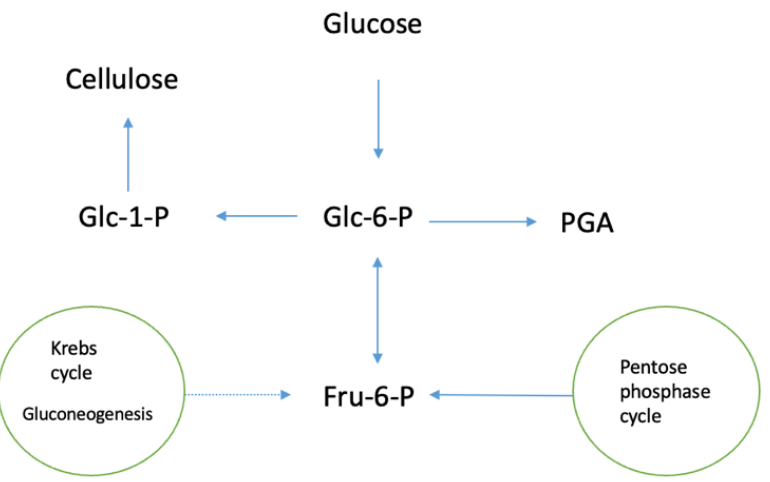
Figure 3. Pathways of carbon metabolism in Acetobacter xylinum , CS, cellulose synthase (adapted from S. Bielecki, A. Krystynowicz, M. Turkiewicz, H. Kalinowska, Bacterial Celluose) [5].